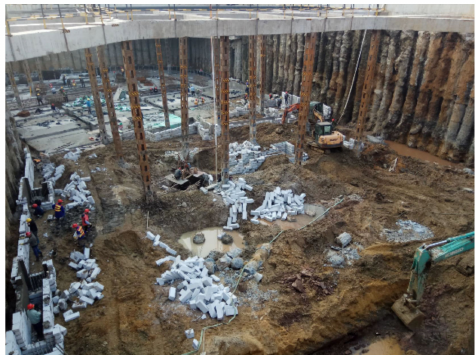
Figure 10. Photo of the site excavation to the